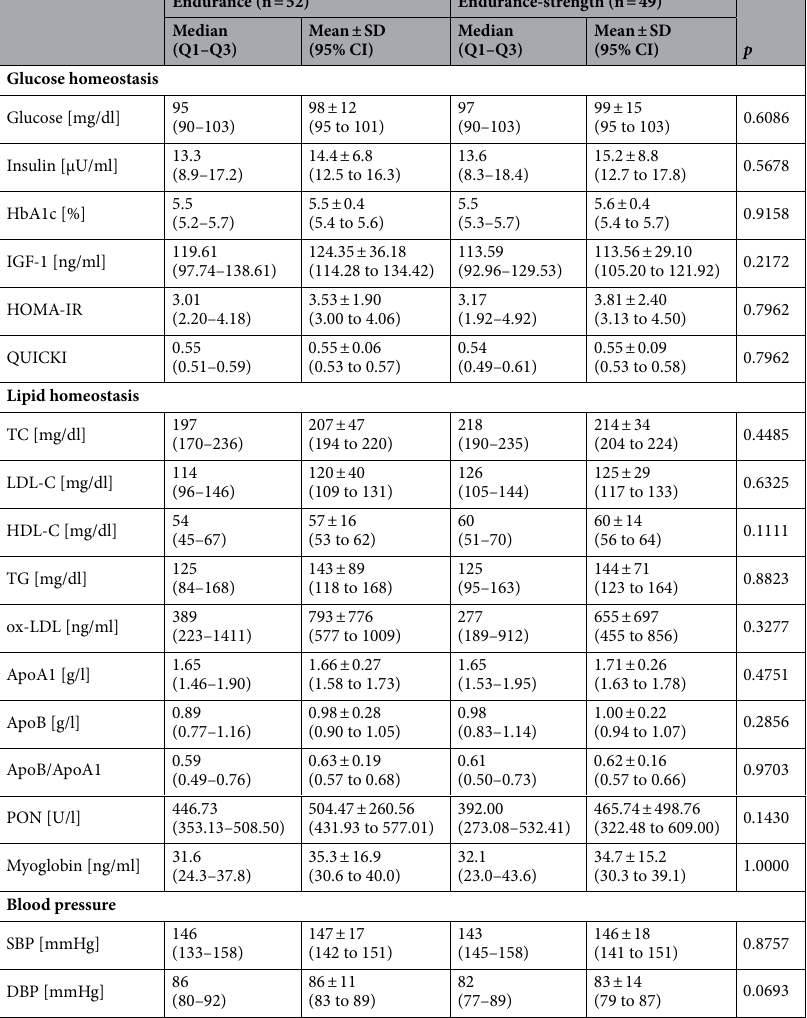
Table 2. Metabolic characteristics of the study population (n = 101). ApoA1 apolipoprotein A1, ApoB , apolipoprotein B, DBP diastolic blood pressure, HbA1c glycated haemoglobin, HDL-C high-density lipoprotein systolic blood pressure, TC total cholesterol, TG triglycerides, QUICKI quantitative insulin sensitivity check